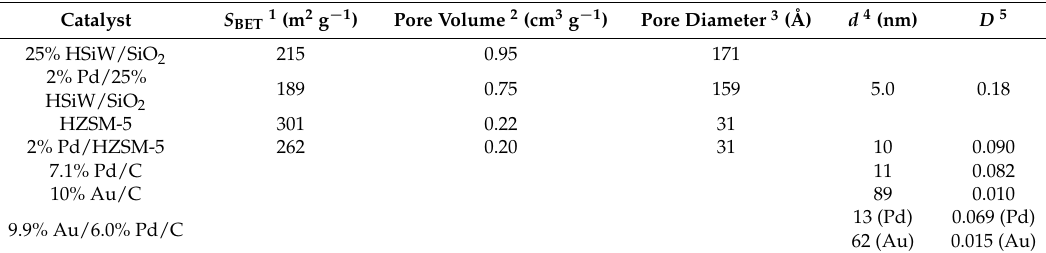
Table 3. Catalyst characterisation.